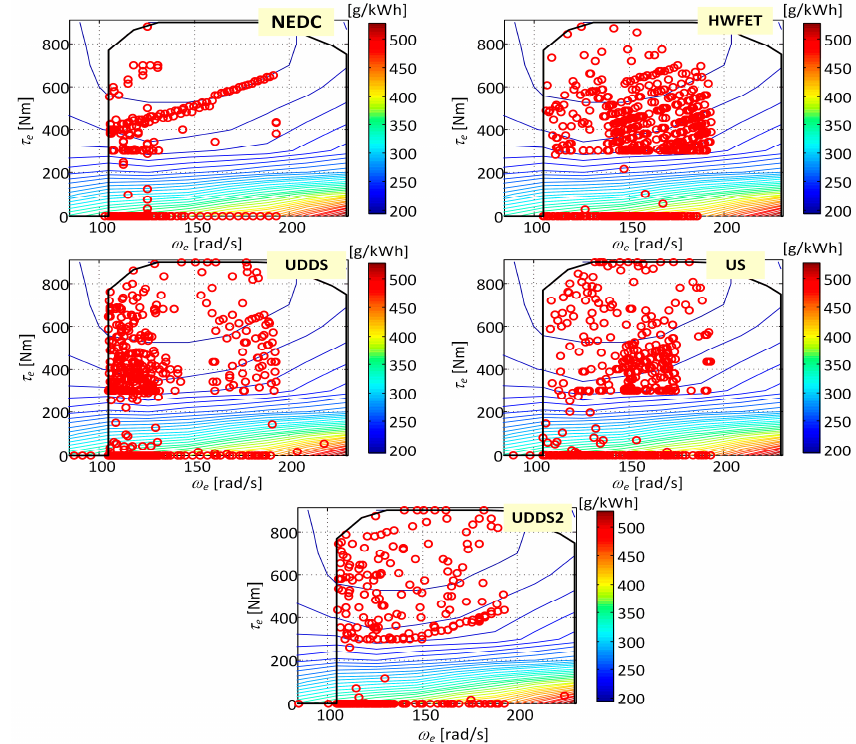
Figure 7. Optimum operating points of ICE obtained by DP optimization for different driving cycles.